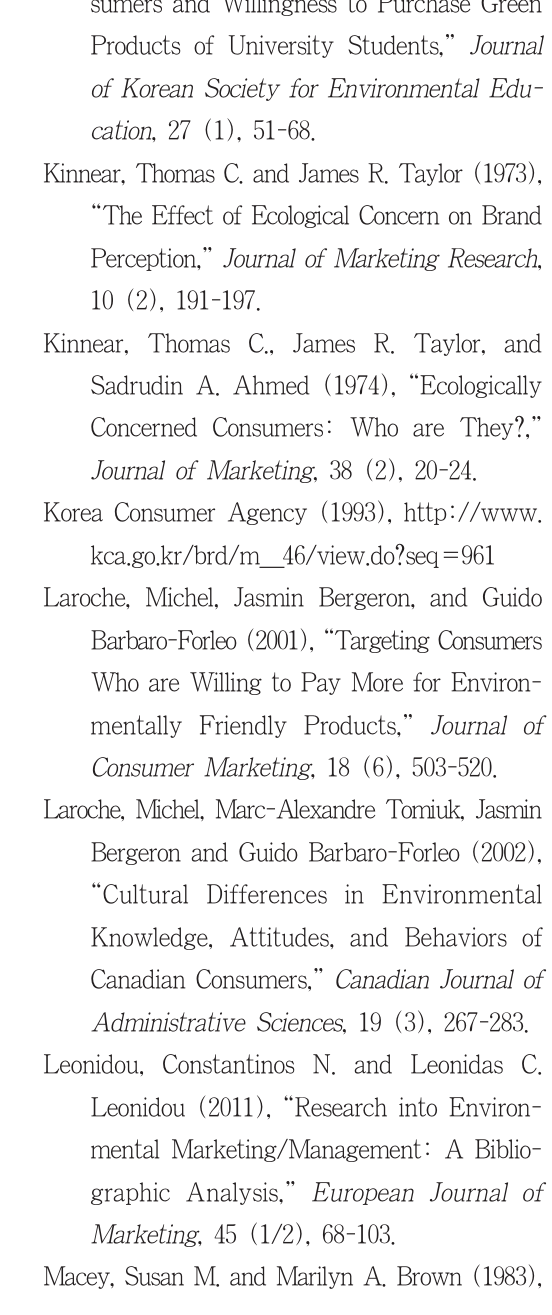
A Study on Green Consumer Segmentation Based on Socio-Demographics and Behavioral Responses: Renewing the Relationships between Socio-demographics and Green Behavior